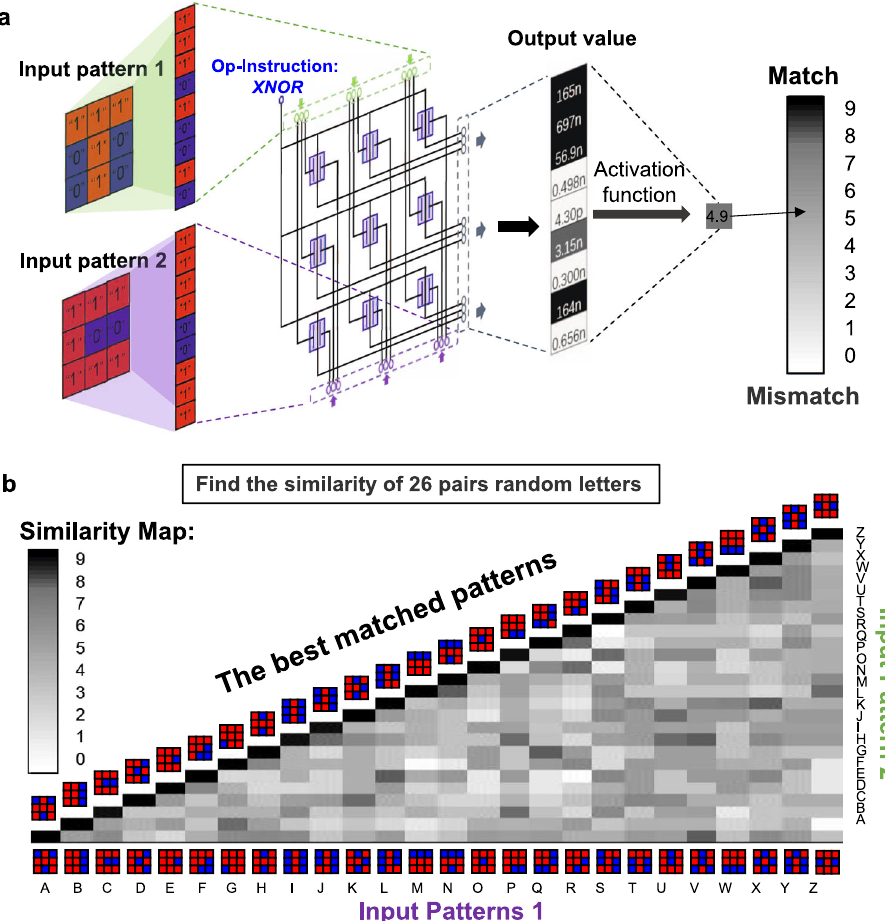
Fig. 5 Demonstration of the image comparing function based on logic XNOR . a Diagram of the working process of image similarity function. Two 3 × 3- pixel patterns are input in parallel from each of the two input ports of the array. The current at each pixel is processed by the activation function and then summed, end up with a value between 0 and 9 to represent the similarity of the image. b A custom 3 × 3-pixel alphabetic A – Z patterns are shown in the horizontal axis. Using the processing method in a , we made a pairwise comparing of the 26 letter patterns, the activated value map is obtained. The best- matched patterns on the diagonal indicate that it realises the function of image Data availability Relevant data supporting the key fi ndings of this study are available within the article and the Supplementary Information fi le. All raw data generated during the current study are available from the corresponding authors upon reasonable request.